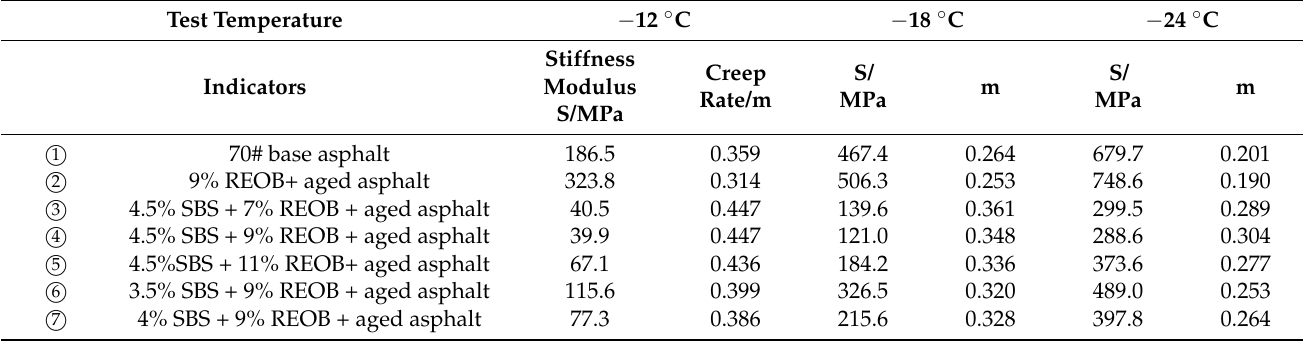
Table 10. BBR bending creep test results of PAV aged asphalt.